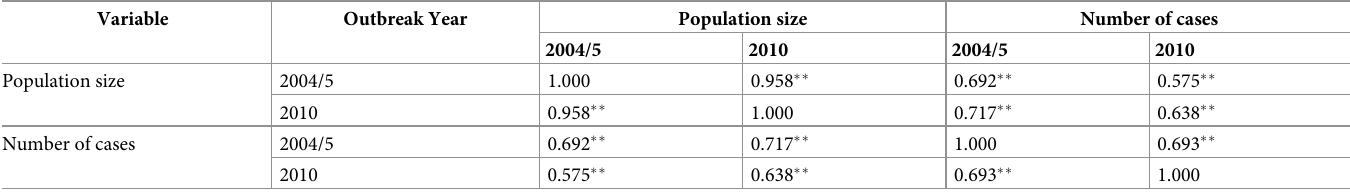
Table 1. Spearman’s bivariate correlations for linear associations between hippo cases and population size in 2004/5 and 2010 outbreaks.